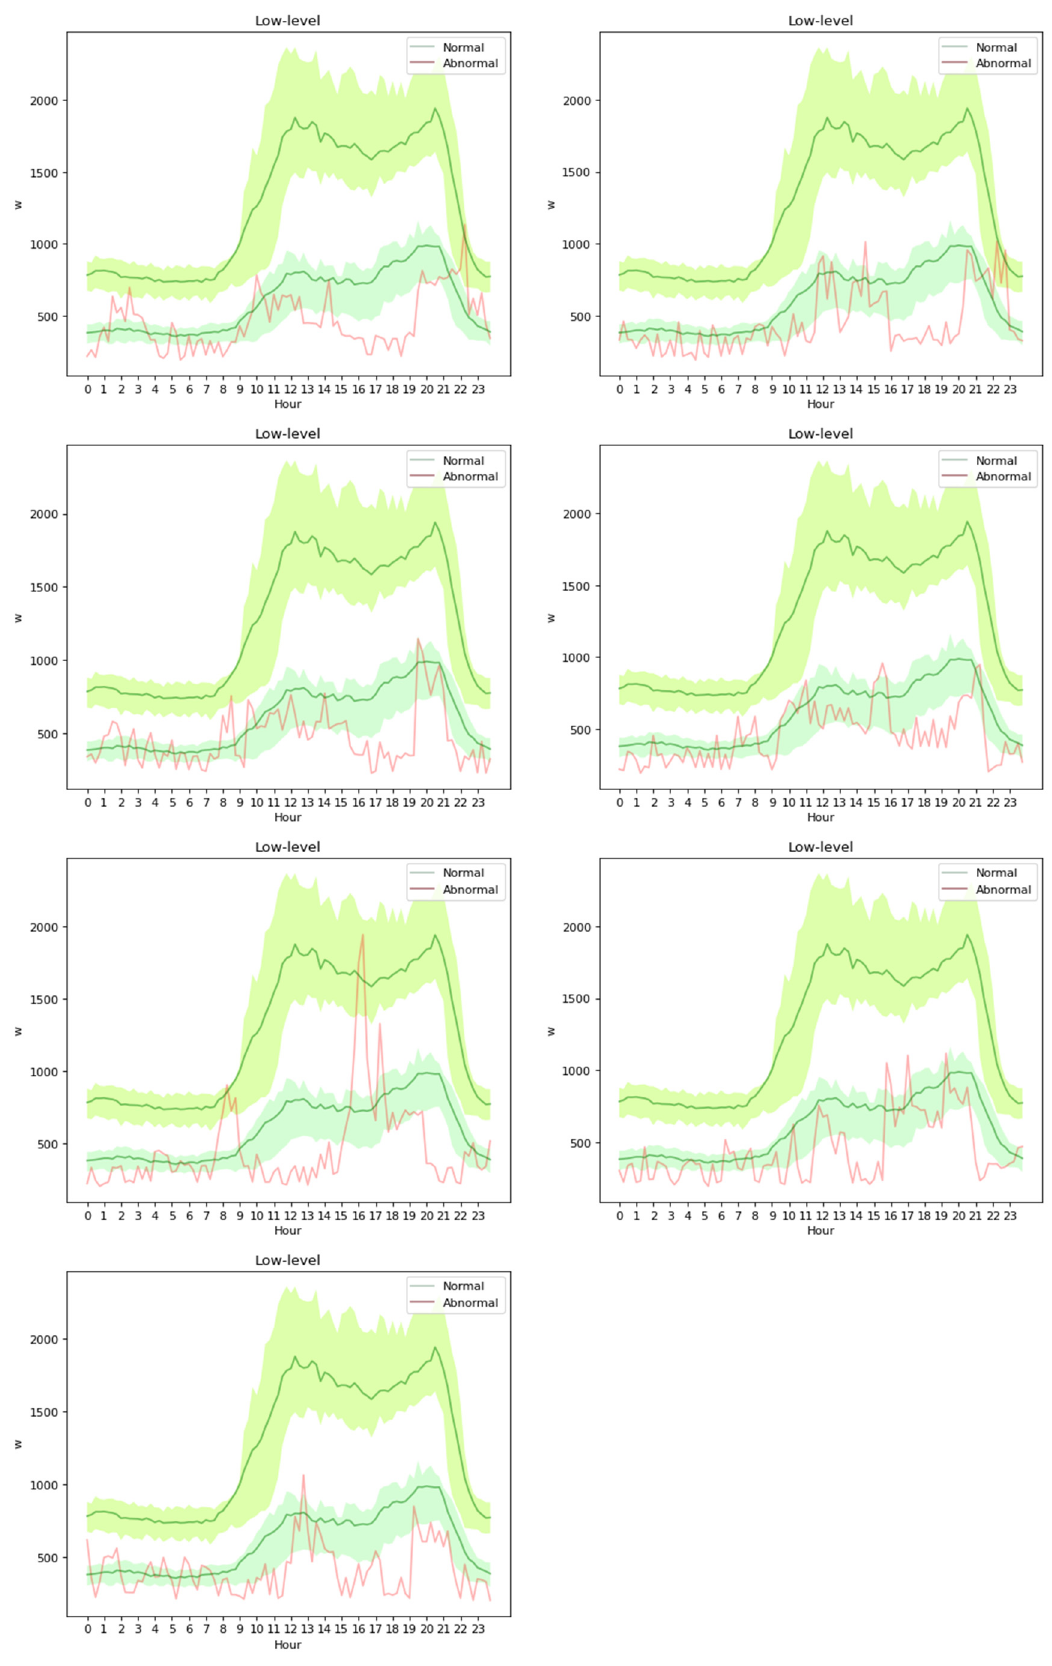
Figure A9. Load profiles of each abnormal electricity consumption events of User 05 using the low-level features.